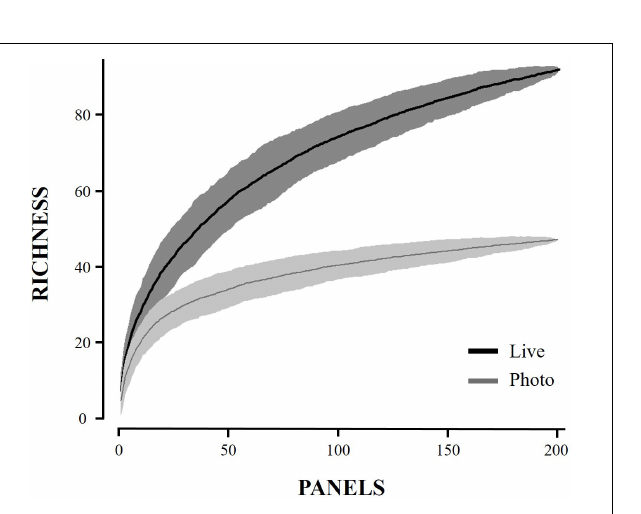
FIGURE 3 | Species accumulation curve for the two point count